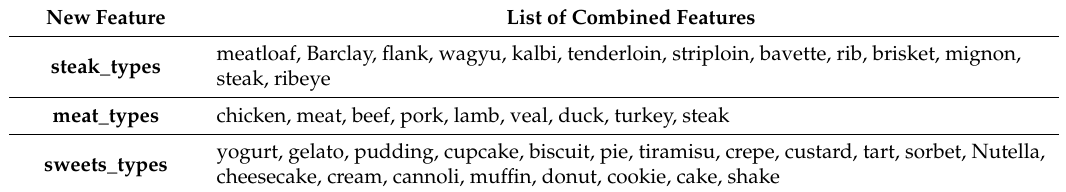
Table A2. List of Features Generated by